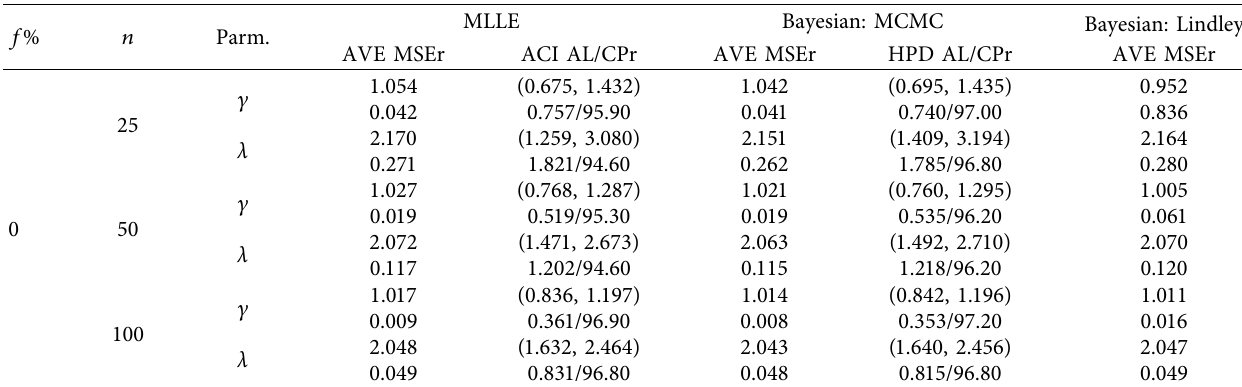
Table 6: Numerical results of AVEs, ACIs, MSErs, ALs, and CPrs (in %) for c � 1 and λ � 2 under number of stages m � 5. MLLE Bayesian: f % n Parm.